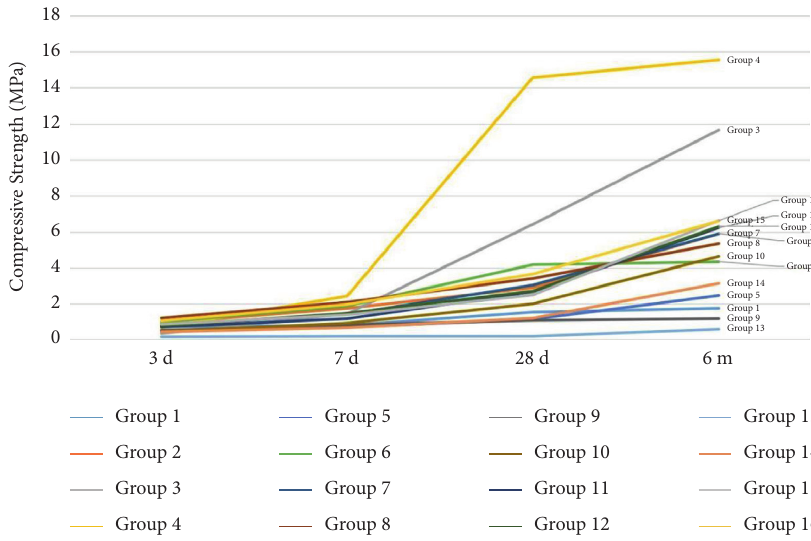
Figure 3: Variation trends of the compressive strength levels.